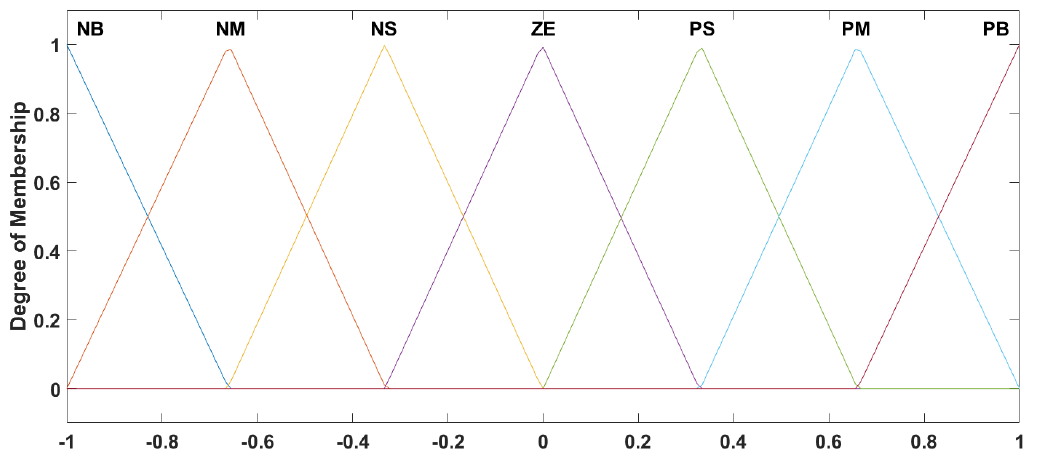
Figure 7. Membership function of E , EC , ∆ K p ( k ) , ∆ K i ( k ) , ∆ K d ( k ) .